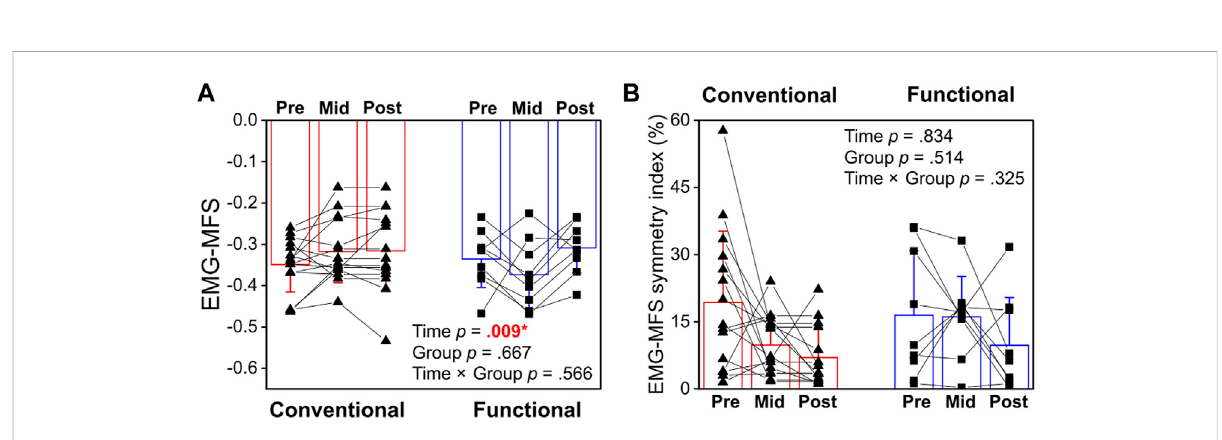
FIGURE 6 (A) Comparison of electromyography median frequency slope (EMG-MFS) between the Conventional and Functional groups at pre-, mid- and post-intervention. (B) ChangesinsymmetryindexofEMG-MFSovertimebetweenconventionalandfunctionaltraining.*Statisticalsigni fi cance( p < 0 .05) is shown in red font and indicated by an asterisk.